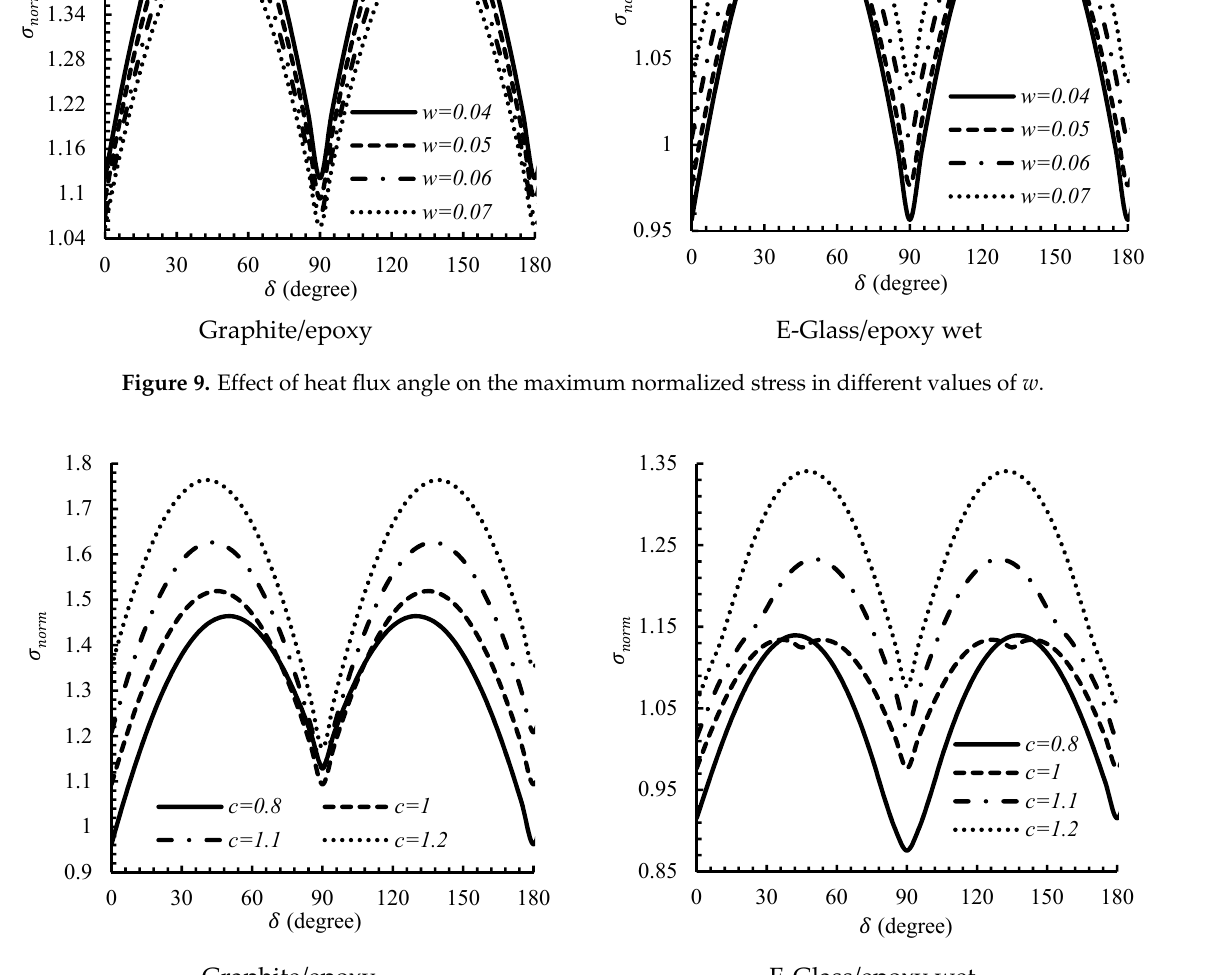
Figure 9. Effect of heat flux angle on the maximum normalized stress in different values of w.